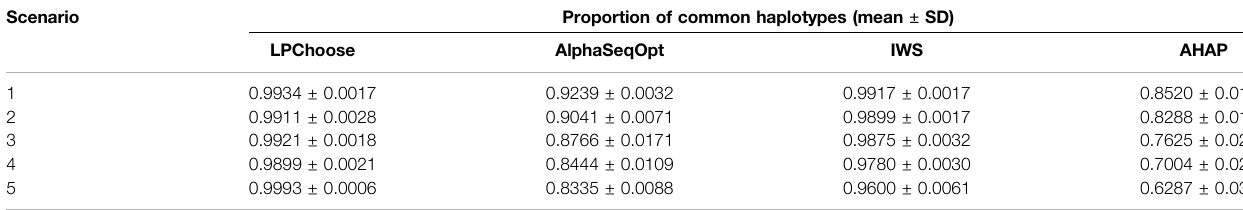
TABLE 4 | Proportion of common haplotypes represented by 100 selected animals in the population.